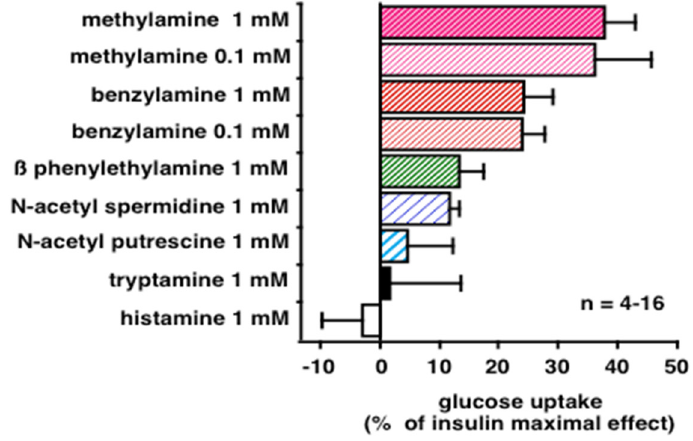
Figure 5. Effect of natural amines on glucose uptake in human adipocytes. Suspensions of human fat cells (15–20 mg lipids/400 µL) were incubated 45 min without (basal, 0%), with 100 nM insulin (max, 100%) or with the indicated concentrations of amines, then [ 3 H]-2-deoxyglucose uptake was assayed on 10-min period. Mean ± SEM of 4–16 adipocyte preparations.